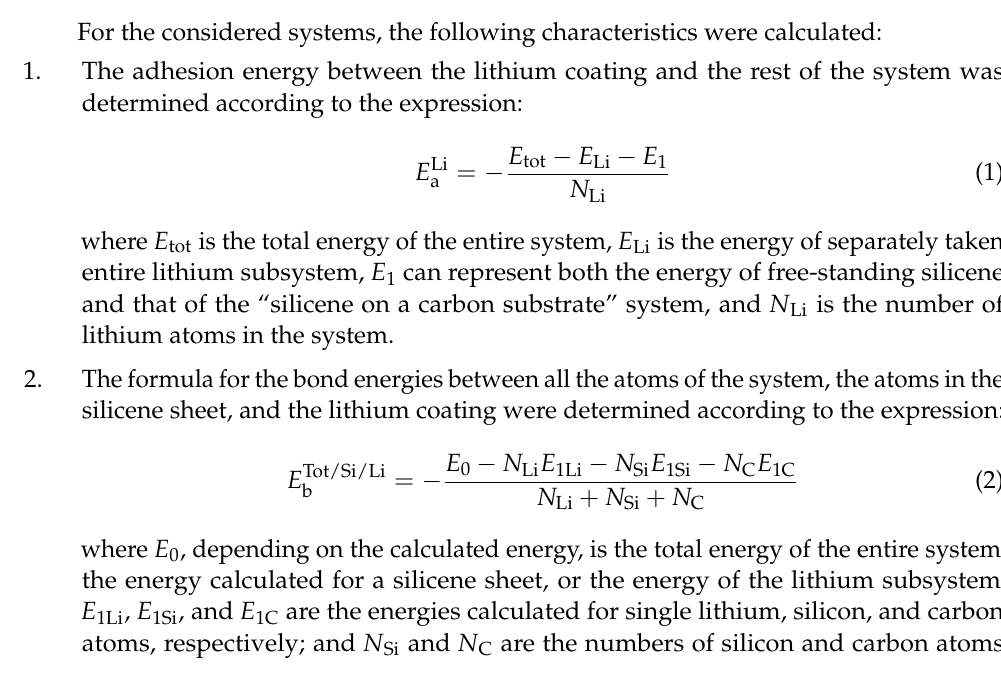
Figure 1. Top and side views of the configuration of the “silicene-bilayer graphene” system after geometric optimization; the top insert shows the direction of the x and y axes relative to the silicene 4 × 2 supercell.